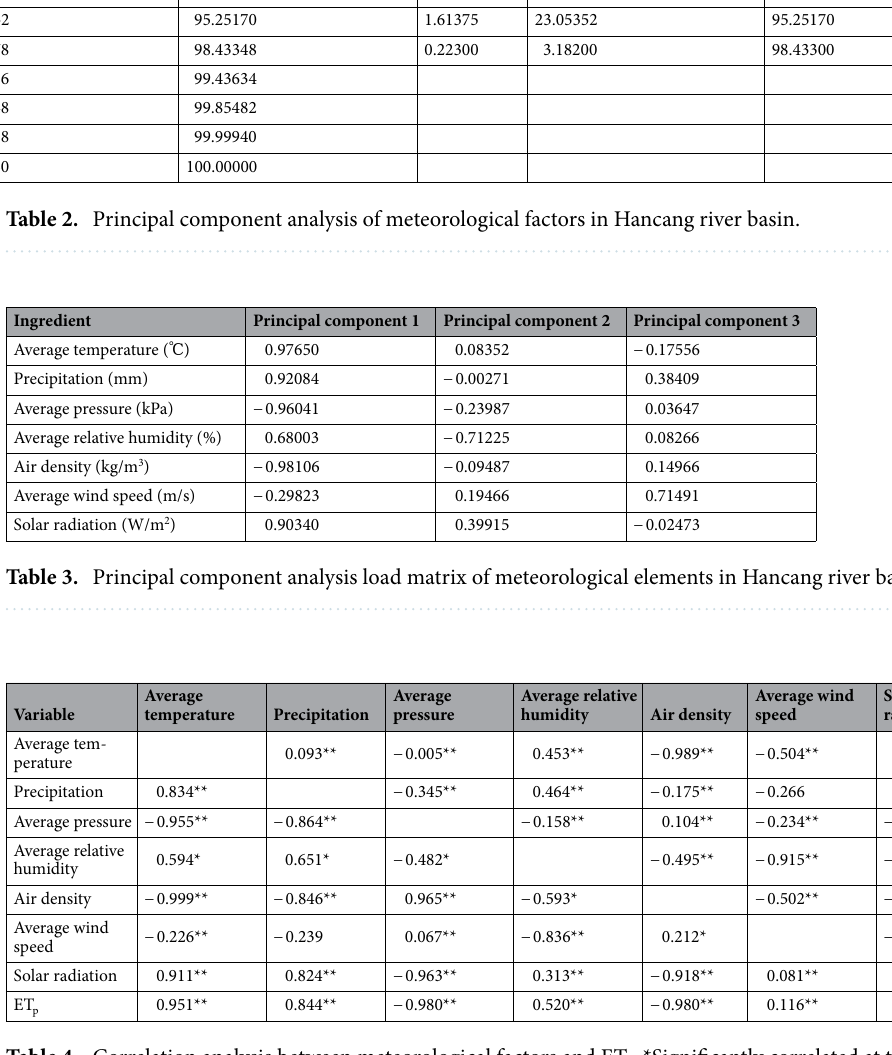
Table 4. Correlation analysis between meteorological factors and ET p . *Significantly correlated at the 0.05 level. **Significantly correlated at the 0.01